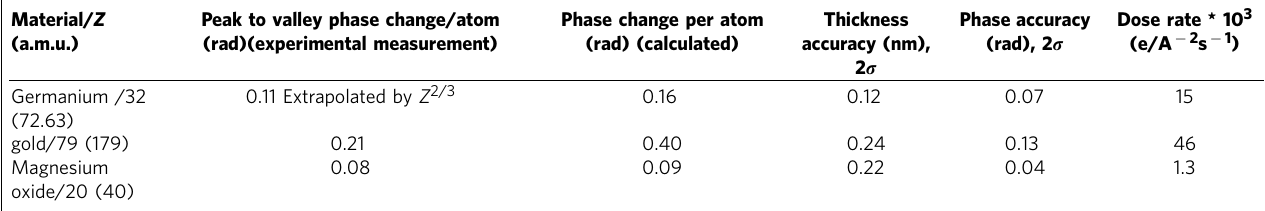
Table 1 | Phase change/atom, accuracy in the mass phase and dose rate for Ge, Au and MgO. Material/ Z (a.m.u.)